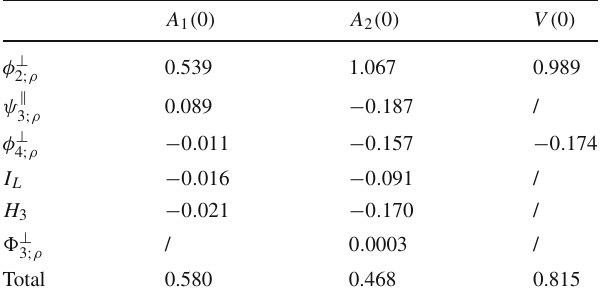
Table 2 Contributions from the LCDAs with various twist structures forthe D → ρ TFFs A 1 , 2 ( 0 ) and V ( 0 ) ,inwhichonlythemainnon-zero